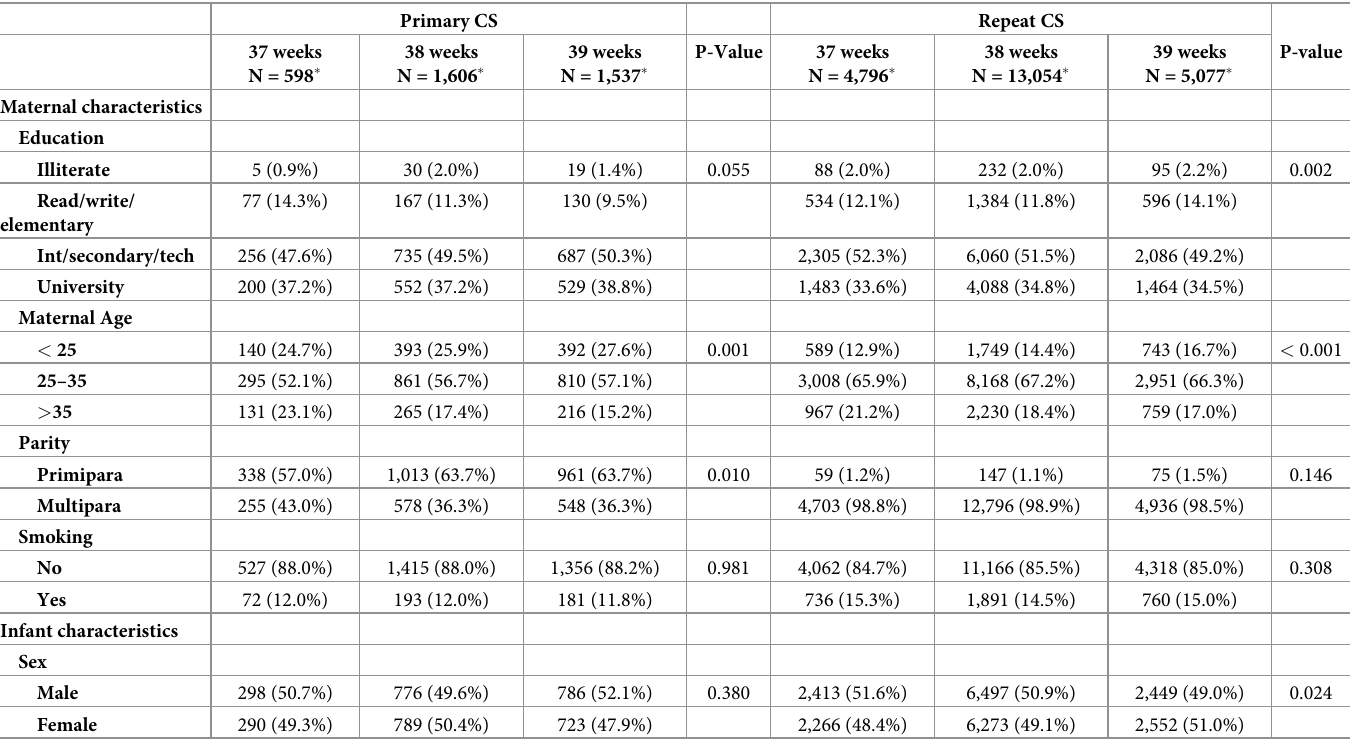
Table 1. Maternal and infant characteristics among women with primary and repeat CS by gestational